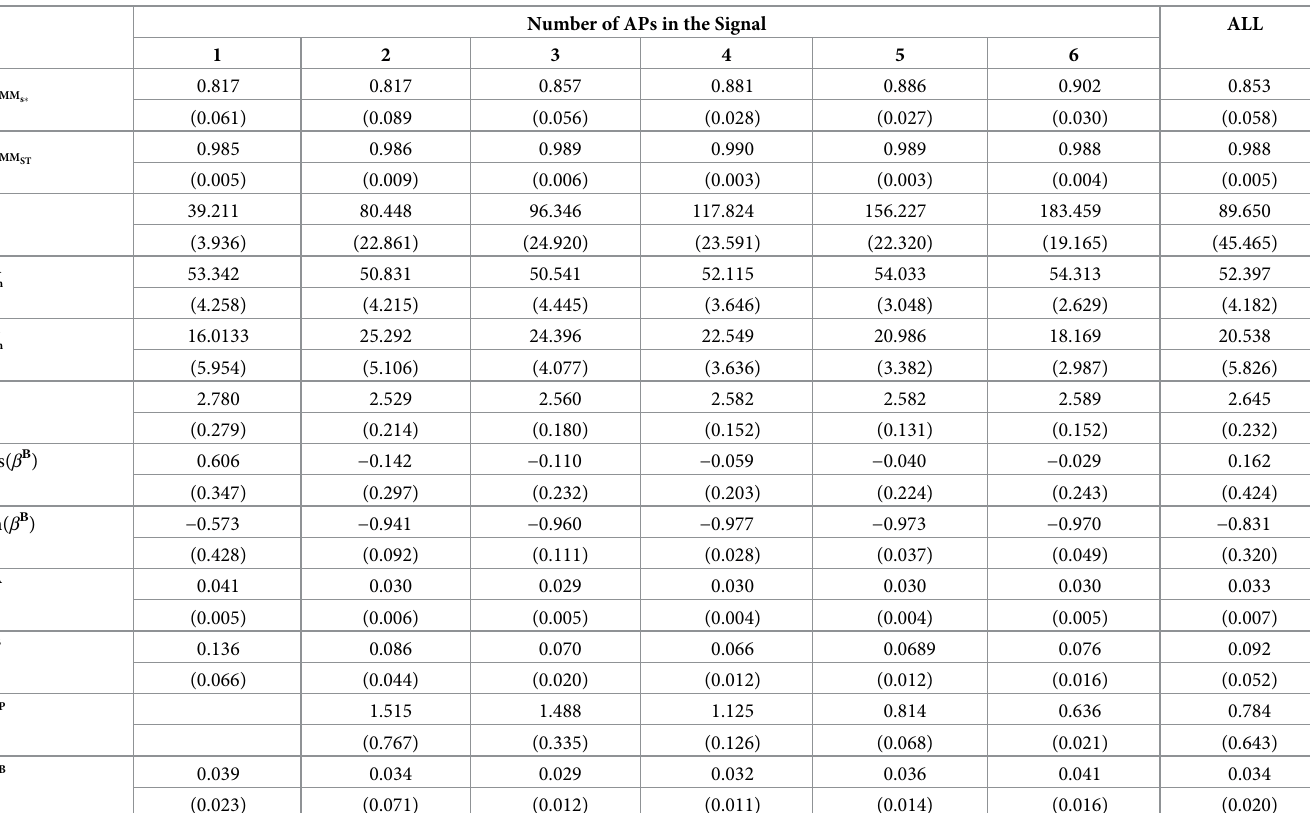
Table 2. Means and standard deviations for R 2 values and parameter